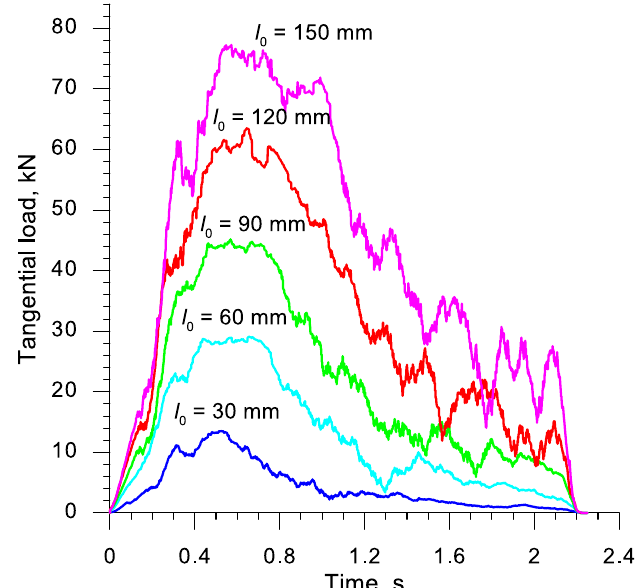
Figure 6. Progression of the sample shape, with the distribution of the effective strain, in the process of rotational compression of a sample with the initial length equal 90 mm (the upper tool was hidden for better visibility).